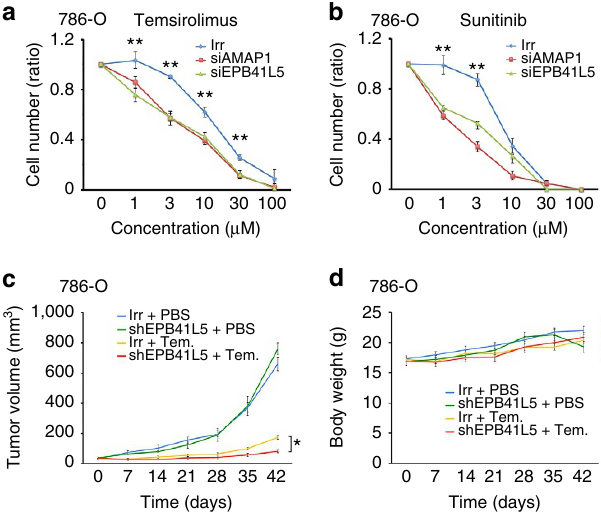
Figure 7 | The Arf6-based mesenchymal pathway in drug resistance. ( a , b ) Silencing of AMAP1 and EPB41L5 enhances the drug sensitivity of 786-O cells. 786-O cells, pretreated with siRNA duplexes for AMAP1 or EPB41L5 , or with an irrelevant sequence (Irr), were treated with Temsirolimus ( a ) or Sunitinib ( b ) at the indicated concentrations for 3 days, and numbers of viable cells were then analysed. Data are presented as ratios, by normalizing values obtained by setting the untreated cells of each siRNA treatment as 1.0. Error bars show the mean ± s.e.m., n ¼ 3. * P o 0.05, ** P o 0.01. Statistical analyses were performed using analysis of variance. ( c , d ) 786-O cells treated with shRNAs for EPB41L5 (shEPB41L5) or an irrelevant sequence (Irr), were subcutaneously injected into nude mice. Ten days after injection, mice were randomized into two groups, those treated with Temsirolimus (10mgkg (cid:2) 1 ) ( þ Tem.) and those treated with PBS ( þ PBS) on a QDx5 schedule, and their tumour sizes ( c ) and body weights ( d ) were monitored for further 6 weeks, as indicated. Error bars show the mean ± s.e.m., n ¼ 6. * P o 0.05. Statistical analyses were performed using Student’s t -test. Chemicals, and SecinH3 was from Santa Cruz (853625-60-2). Other chemicals were purchased from Wako Chemicals, unless otherwise indicated. Since Y27632 did not inhibit cell invasiveness in our experiments, which used renal cancer cells, we confirmed the activity of Y27632 by its inhibition of the amoeboid-type invasion of HT1080 cells, as described previously 22 . Antibodies and immunoblotting analyses . Affinity-purified rabbit polyclonal antibodies against human GEP100 and human AMAP1, and mouse polyclonal antibodies against human EFA6B were as described previously 10,11 . Rabbit polyclonal antibodies against human EPB41L5 were generated using a GST-fused peptide corresponding to amino acids (aa) 541–733. The resulting sera were first adsorbed with GST protein, and then affinity-purified using the antigen peptides. Other antibodies were purchased from the following commercial sources: mouse monoclonal antibodies against Arf6 (1:1,000, Santa Cruz), AMAP1 (1:2,000, Santa Cruz), HA-tag (1:1,000, Covance) and b -actin (1:5,000, UBI); and rabbit polyclonal antibodies against G a 12 (1:1,000, Santa Cruz Biotechnology), G a 13 (1:1,000, Sigma-Aldrich), G a q (1:1,000, Santa Cruz Biotechnology), G a i2 (1:1,000, Santa Cruz Biotechnology), G b 1 (1:1,000, Upstate Biology), EFA6B (1:1,000, Sigma- Aldrich) and EFA6D (1:1,000, Santa Cruz). Donkey antibodies against rabbit and mouse IgG, each conjugated with horseradish peroxidase, were from Jackson Uncropped images of immunoblot are provided in Supplementary Figs 11–13.